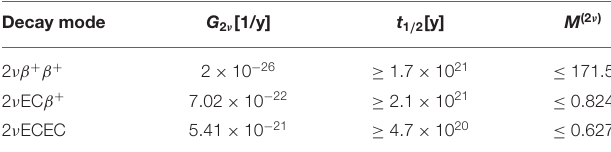
TABLE 1 | Phase-space factors [ 16], half-lives [8], and the resulting experimental NMEs of different decay modes of 106 Cd. Decay mode G 2 ν